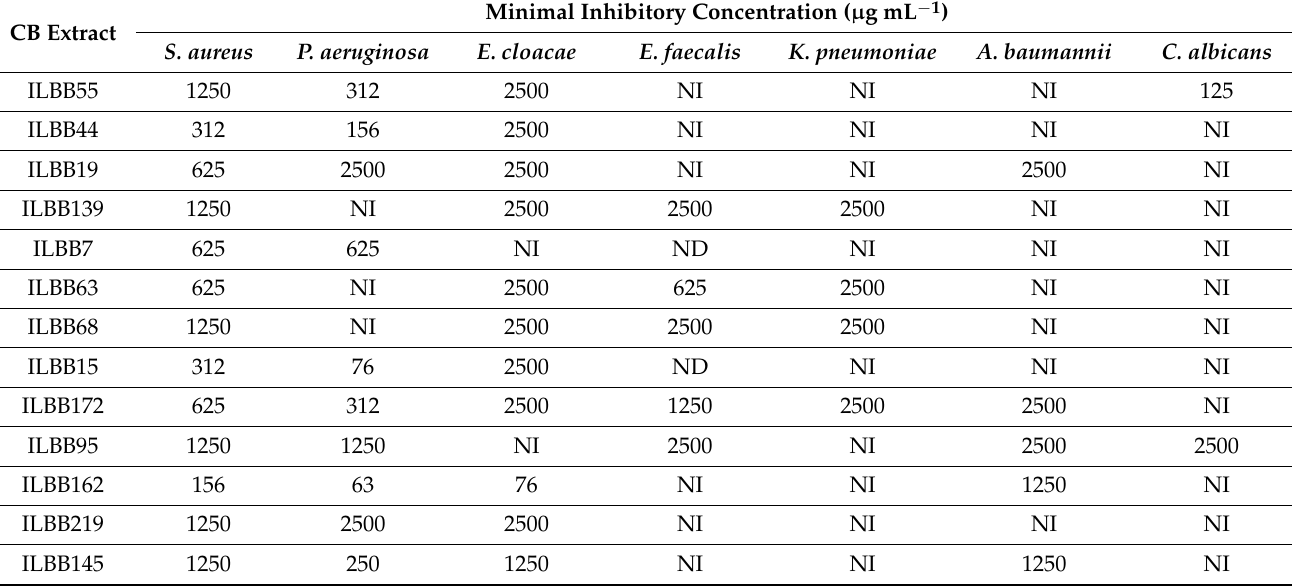
Table 2. Determination of minimal inhibitory concentration of the extracts against planktonic